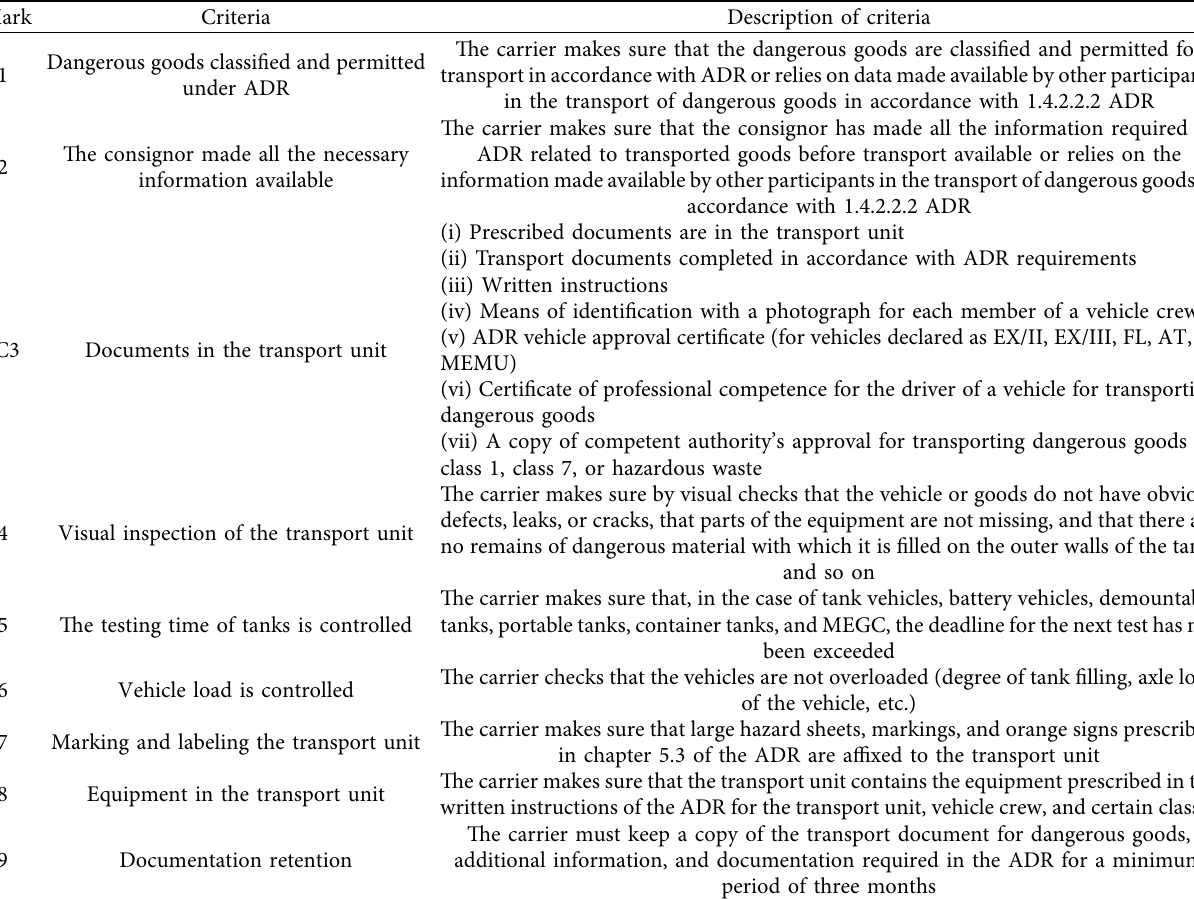
Table 2: List and definition of criteria applied in this study.